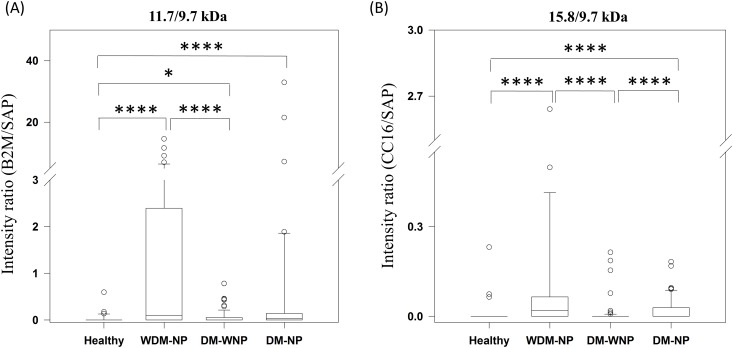
Excretion of (A) 11.7 kDa and (B) 15.8 kDa proteins in urine samples from 39 healthy, 44 WDM-NP, 85 DM-WNP, and 51 DM-NP subjects.The relative intensities are represented as box plots, expressed as the medium with quartile values (25%, 75%). Error bars indicate the minimum and maximum values. * p < 0.05, *** p ≤ 0.001.